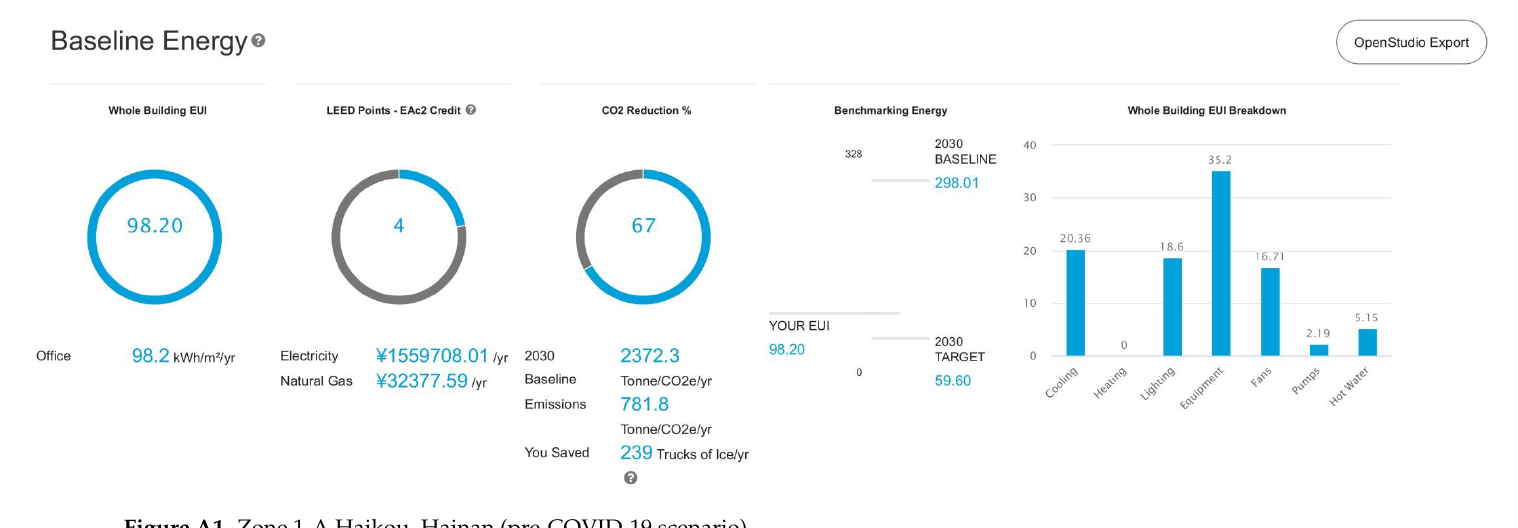
Figure A1. Zone 1-A Haikou, Hainan (pre-COVID-19 scenario).